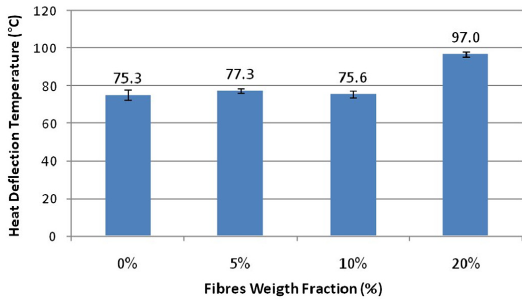
Figure 5. Heat deflection temperature of the curaua composites.